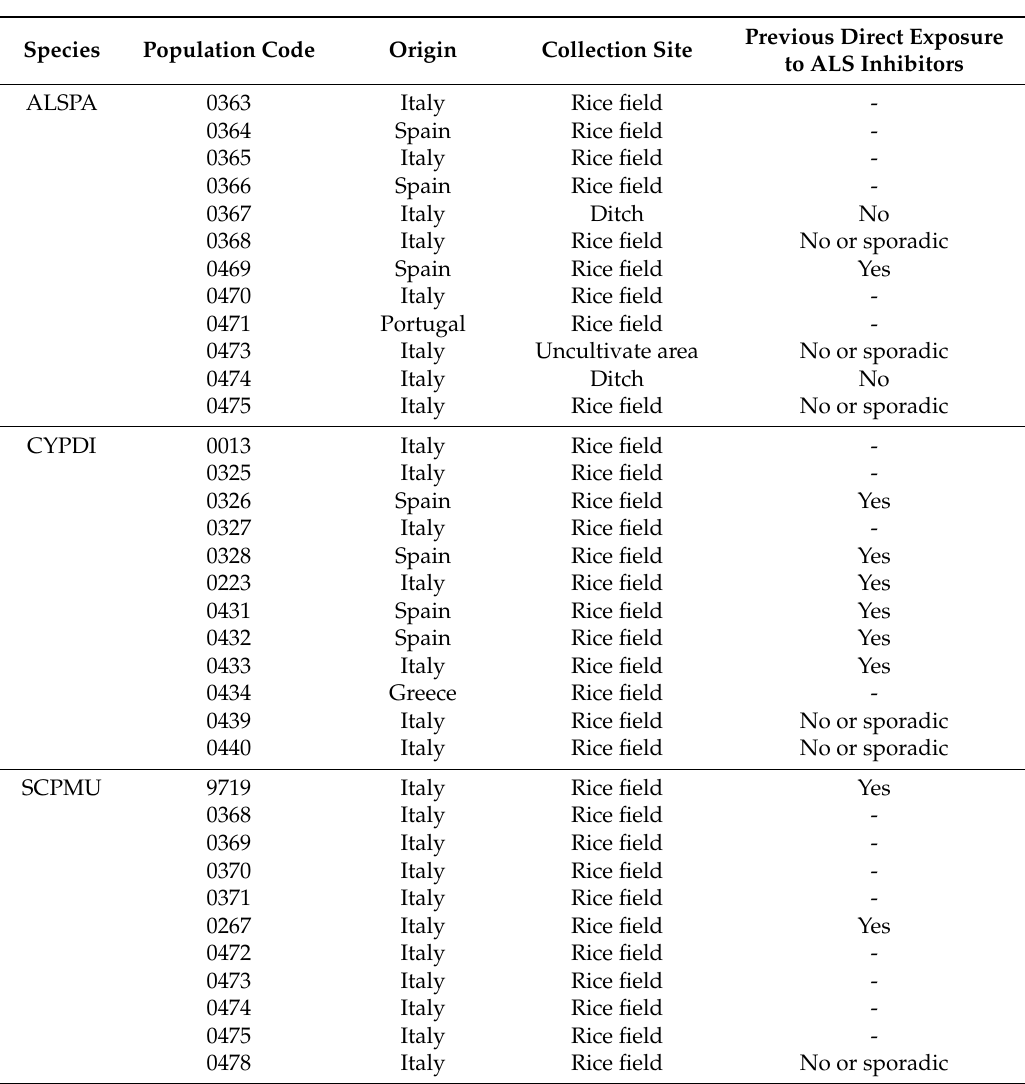
Table 1. Country of origin, collection site and available information on previous exposure